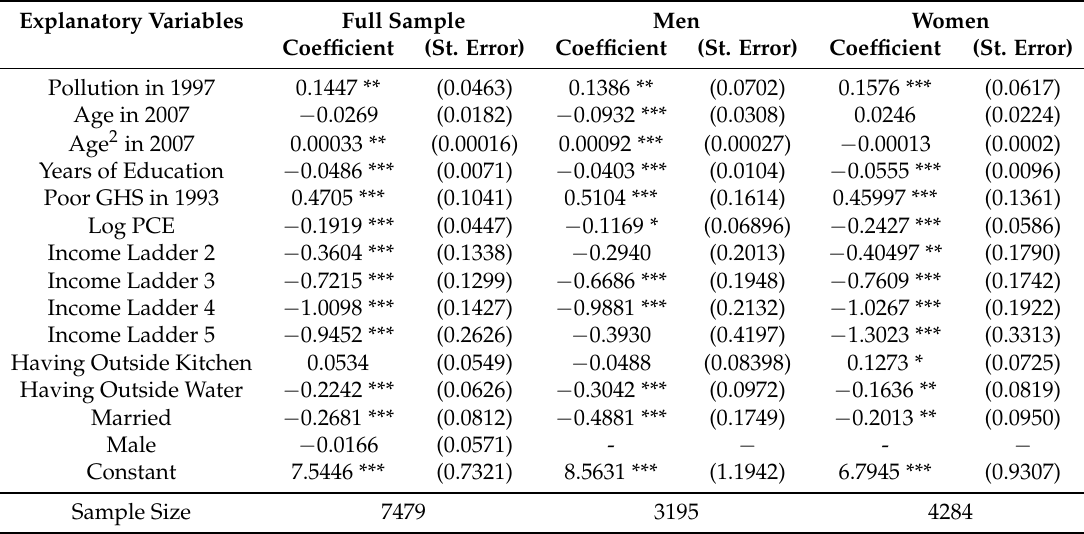
Table 4. The Effects of Pollution on Mild Depressive Symptoms (OLS Regression Results). Explanatory